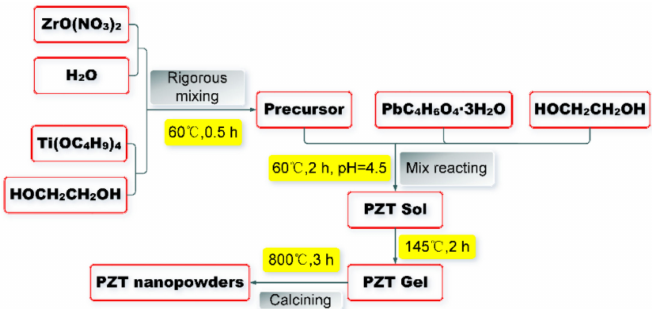
Figure 1. The sol-gel synthesis schematic procedure for lead-zirconate-titanate (PZT) nanoscale